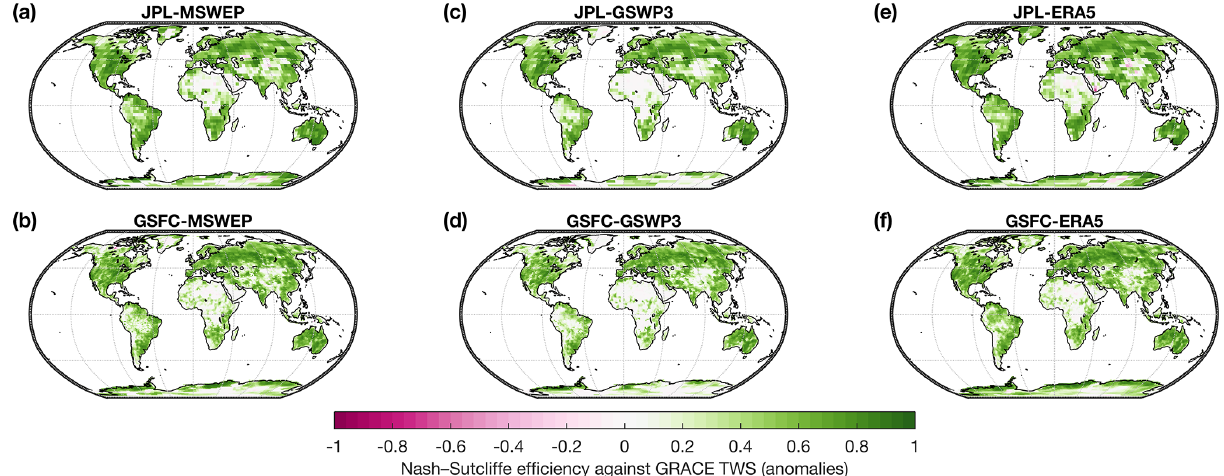
Figure 6. Nash–Sutcliffe efficiency (of de-seasonalized, de-trended anomalies) between GRACE-REC and GRACE JPL mascons (a, c, e) or GRACE GSFC mascons (b, d, f) . Three different precipitation forcing datasets are tested: MSWEP (a, b) , GSWP3 (c, d) , and ERA5 (e, f) . Values closer to 1 correspond to a higher model